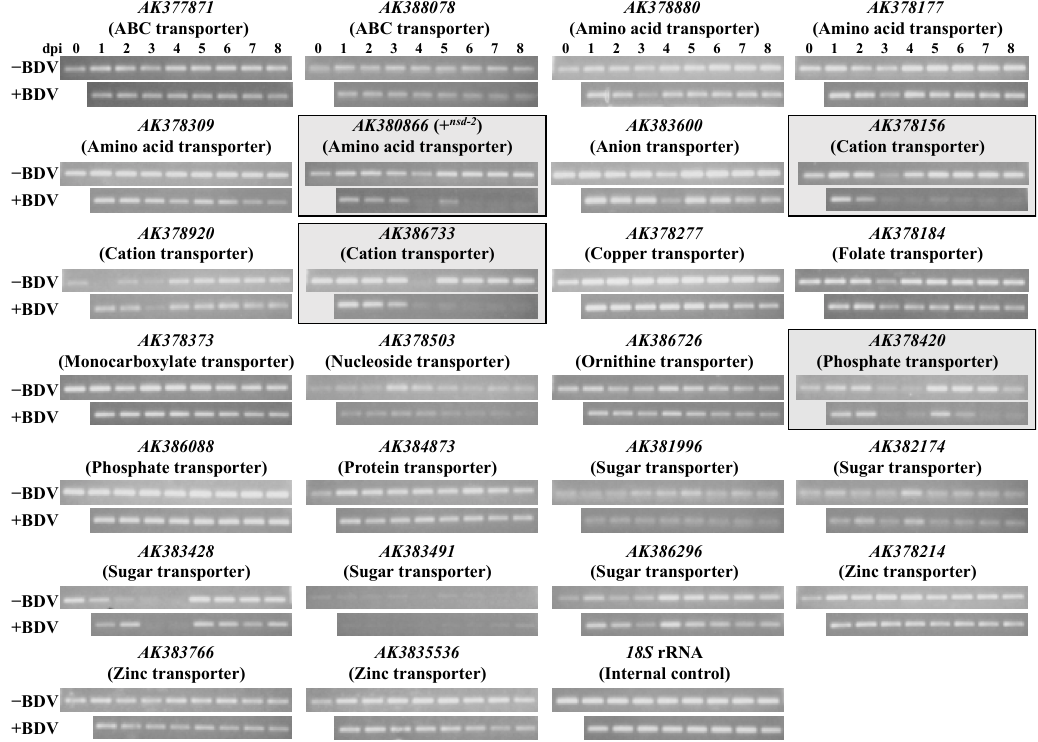
Figure 5. The expression pattern of 26 genes encoding transporter proteins in the midgut of virus-uninfected and virus- infected silkworm larvae. The upper and lower panels show the results of virus-uninfected and virus-infected silkworms, respectively. B. mori 18S rRNA was used as an internal control. The expression levels of four genes: AK380866 (+ nsd-2 ; amino acid transporter), AK378156 (cation transporter), AK386733 (cation transporter), and AK378420 (phosphate transporter) were significantly decreased by virus infection. This figure is a partial modification of Ito et al. [26].